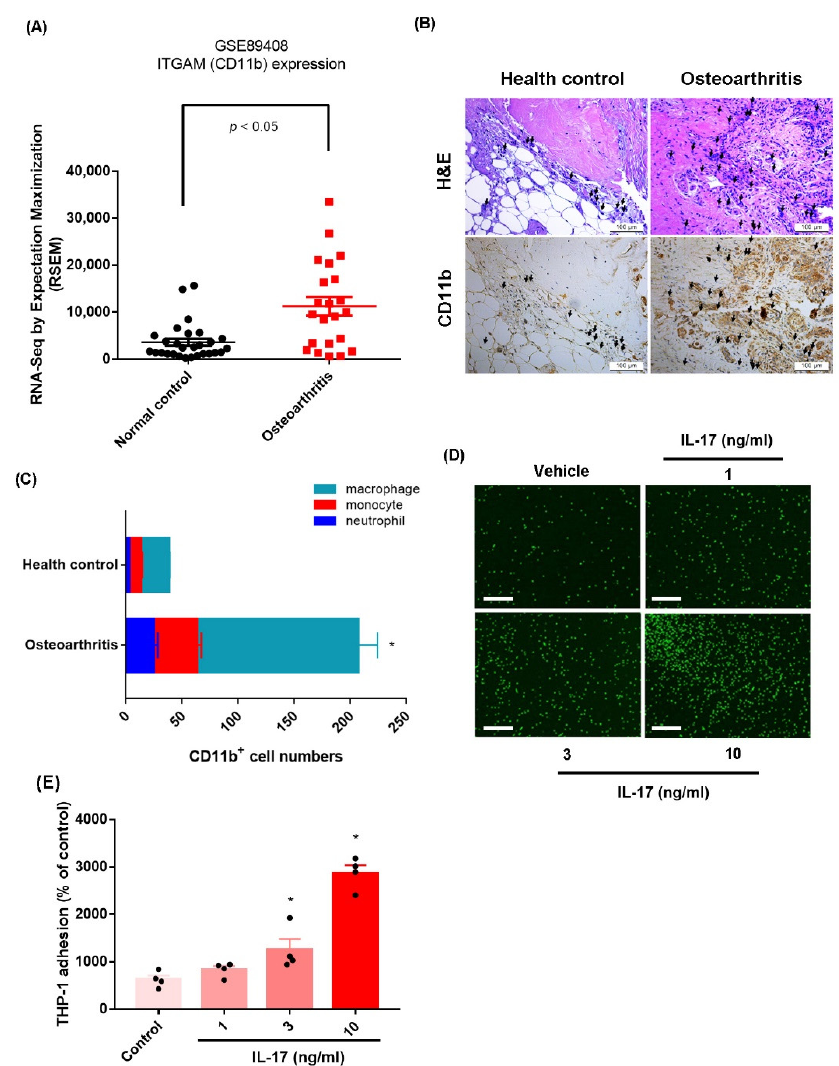
Figure 1. IL-17 promotes monocyte adhesion in OASFs. ( A ) Levels of CD11b were investigated in OA and healthy control synovial tissue collected from the GEO database. ( B , C ) IHC staining for CD11b + (neutrophil, monocyte, and macrophage) in synovium samples from OA patients and healthy individuals. ( D , E ) OASFs were stimulated with vehicle or IL-17 (1–10 ng/mL) for 24 h. Monocytes (THP-1 cells) were then applied to the OASFs. Adherent THP-1 cells were photographed and quantified under fluorescence microscopy. Size bar = 320 μ m. * p < 0.05 compared with the control group.